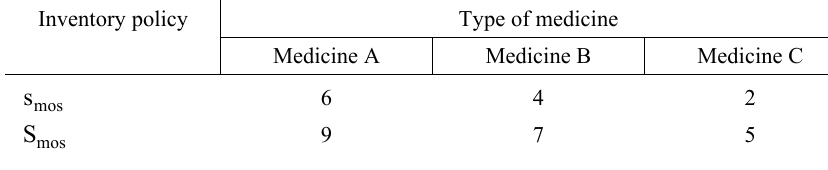
Table 2. Results of OptQuest optimization